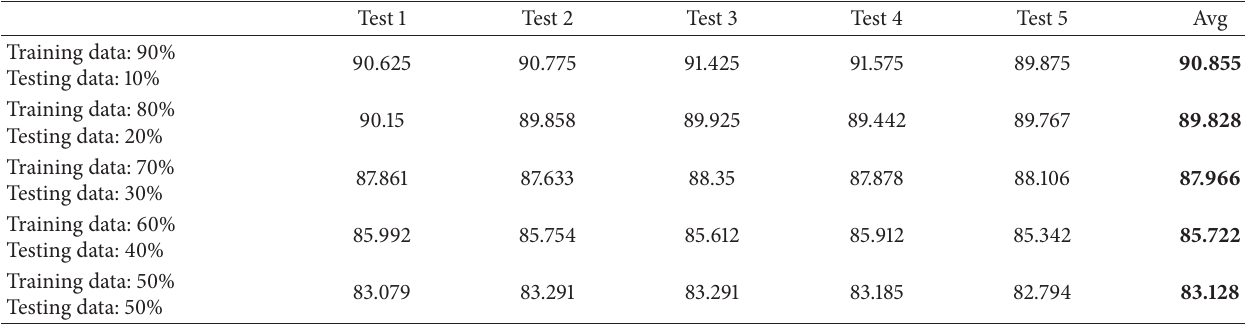
Table 2: Percentage of accuracy test results with five sets of training data and testing data at various proportions. An average was taken from the five tests. The maximum degree of recognition was